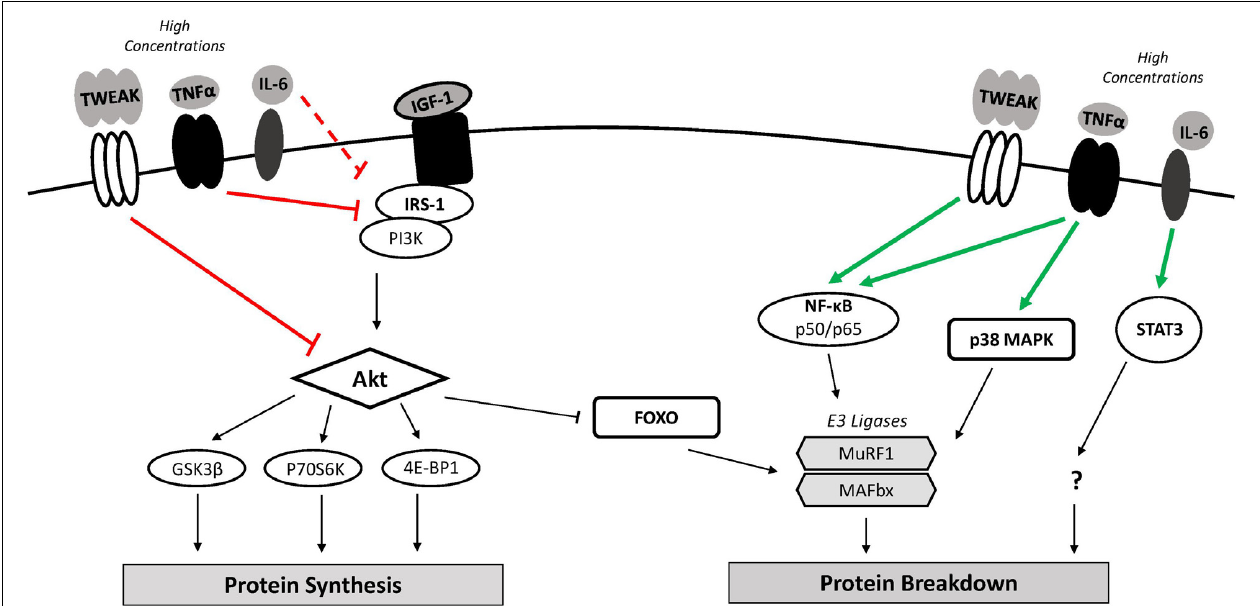
FIGURE 2 | Inflammation and muscle protein turnover. Classical muscle wasting cytokines include TWEAK, TNF α , and IL-6. High concentrations of these cytokines may down-regulate mRNA translation and muscle protein synthesis through inhibition of the PI3K/Akt pathway resulting in GSK3 β inhibition of translation and reduced mTOR activation. Increased FOXO nuclear localization along with classical NF- κ B and p38 MAPK activity increases transcription of atrophy-related genes (i.e., MuRF1, MAFbx). An imbalance where catabolic signaling exceeds anabolic signaling can lead to muscle atrophy. 4E-BP1, 4E binding protein 1; FOXO, forkhead box O; GSK-3 β , glycogen synthase kinase 3 β ; IGF-1, insulin-like growth factor 1; IL-6, interleukin-6; IRS-1, insulin receptor substrate 1; MAFbx, muscle atrophy F-box; mTOR, mammalian target of rapamycin; MuRF1, muscle ring finger 1; NF- κ B, nuclear factor- κ B; p38 MAPK, p38 mitogen-activated protein kinase; p70S6K, p70 ribosomal protein S6 kinase; PI3K, phosphoinositide 3-kinase; STAT3, signal transducer and activator of transcription 3; TNF α , tumor necrosis factor- α ; TWEAK, TNF-like weak inducer of